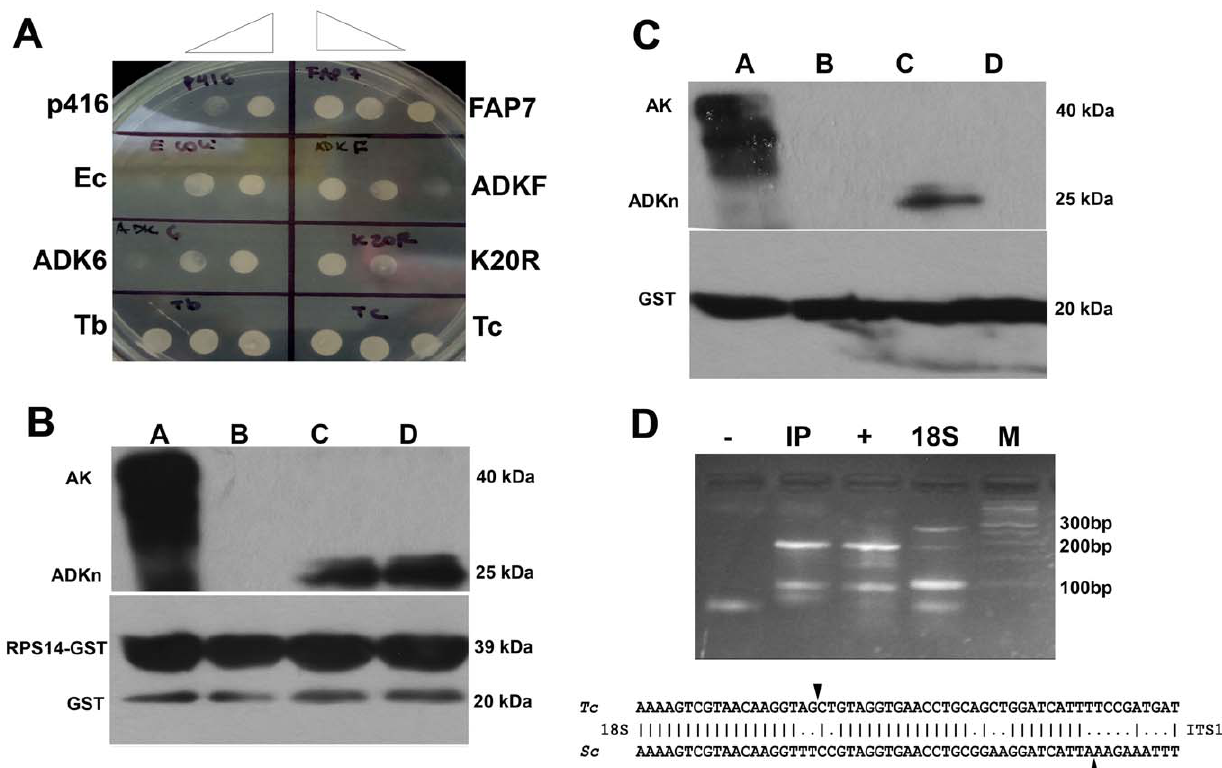
Figure 5. TcADKn role in ribosome biogenesis. A) Yeast complementation assay, Gal HA-FAP7 yeast strain were transformed with TcADKn, TcADKn(K20R), TbADKn, TbADKF ( T. brucei mitochondrial isoform), E. coli ADK, TcADK6 ( T. cruzi mitochondrial isoform) and ScFAP7. After transformation yeast were shifted to selective minimum medium containing glucose. Only yeast carrying TbADKn and TcADKn were able to grow in selective medium. B) In vitro protein interaction assays between recombinant 6xHisTcADKn, 6xHisTcAK and GST-TcRps14. Lane A and B input and output of the interaction assay between 6-His-TcAK and GST-TcRps14, lanes C and D interaction between TcRps14GST- HisTcADKn. Results were analyzed by Western Blot using monoclonal anti-HIS and anti-GST antibodies. C) In vitro protein interaction assays, inputs and outputs respectively between, lanes A and B recombinant 6xHisTcAK and the GST tag, lanes C and D 6xHisTcADKn and the GST tag. Results were analyzed by Western Blot using monoclonal anti-HIS and anti-GST antibodies. D) 18S precursors were isolated using a microRNA isolating system. Total RNA were ligated to an adenylated DNA adapter, followed by cDNA generation and RT-PCR using specific primers for the 18S and for the DNA adapter. Data were analyzed by agarose electrophoresis. Sequence alignment of 18S precursors of site D found in TcADKn immunoprecipitates and the precursor of S. cereviciae